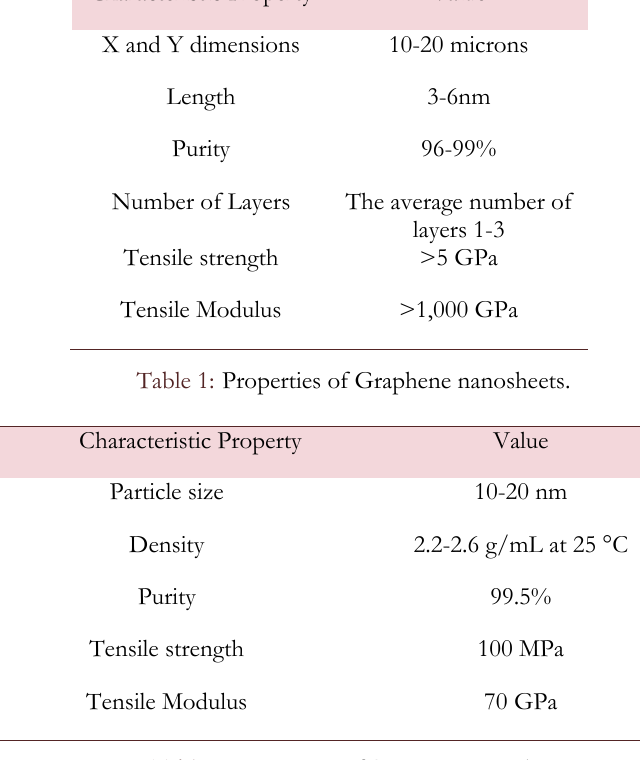
Table 2: Properties of SiO 2